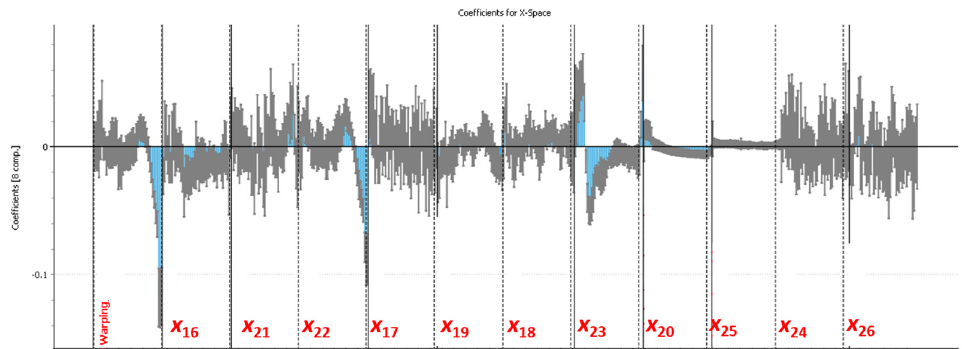
Figure 12. Model coefficients (blue bars) and the confidence interval for a 95% confidence level (grey intervals) associated to each variable for the PLS-DA regression model to predict x 15 = 1 from variables ‘warping profile’ and x 16 to x 26 , fitted with eight LVs [R 2 (Y) = 79.80%; Q 2 (Y) = 71.90]. Positive values indicate that higher values for the corresponding variable at that point in the batch are expected, on average, for batches with x 15 = 1 (Premix 2 used).